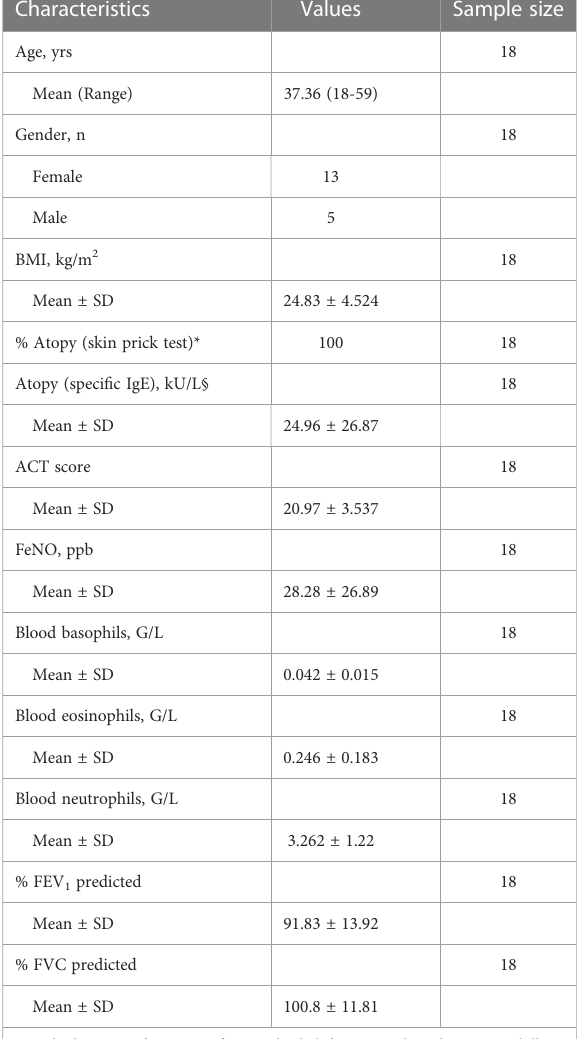
TABLE 2 Characteristics of the patient